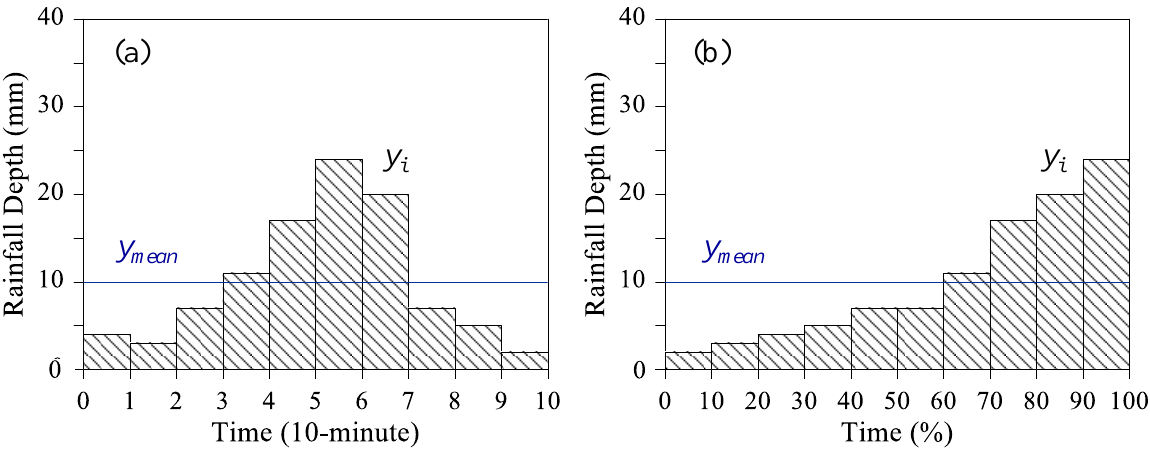
Figure 4. Example of the calculation of the Schutz index by using rainfall data: ( a ) original rainfall event and ( b ) sorted nondecreasing rainfall depth.